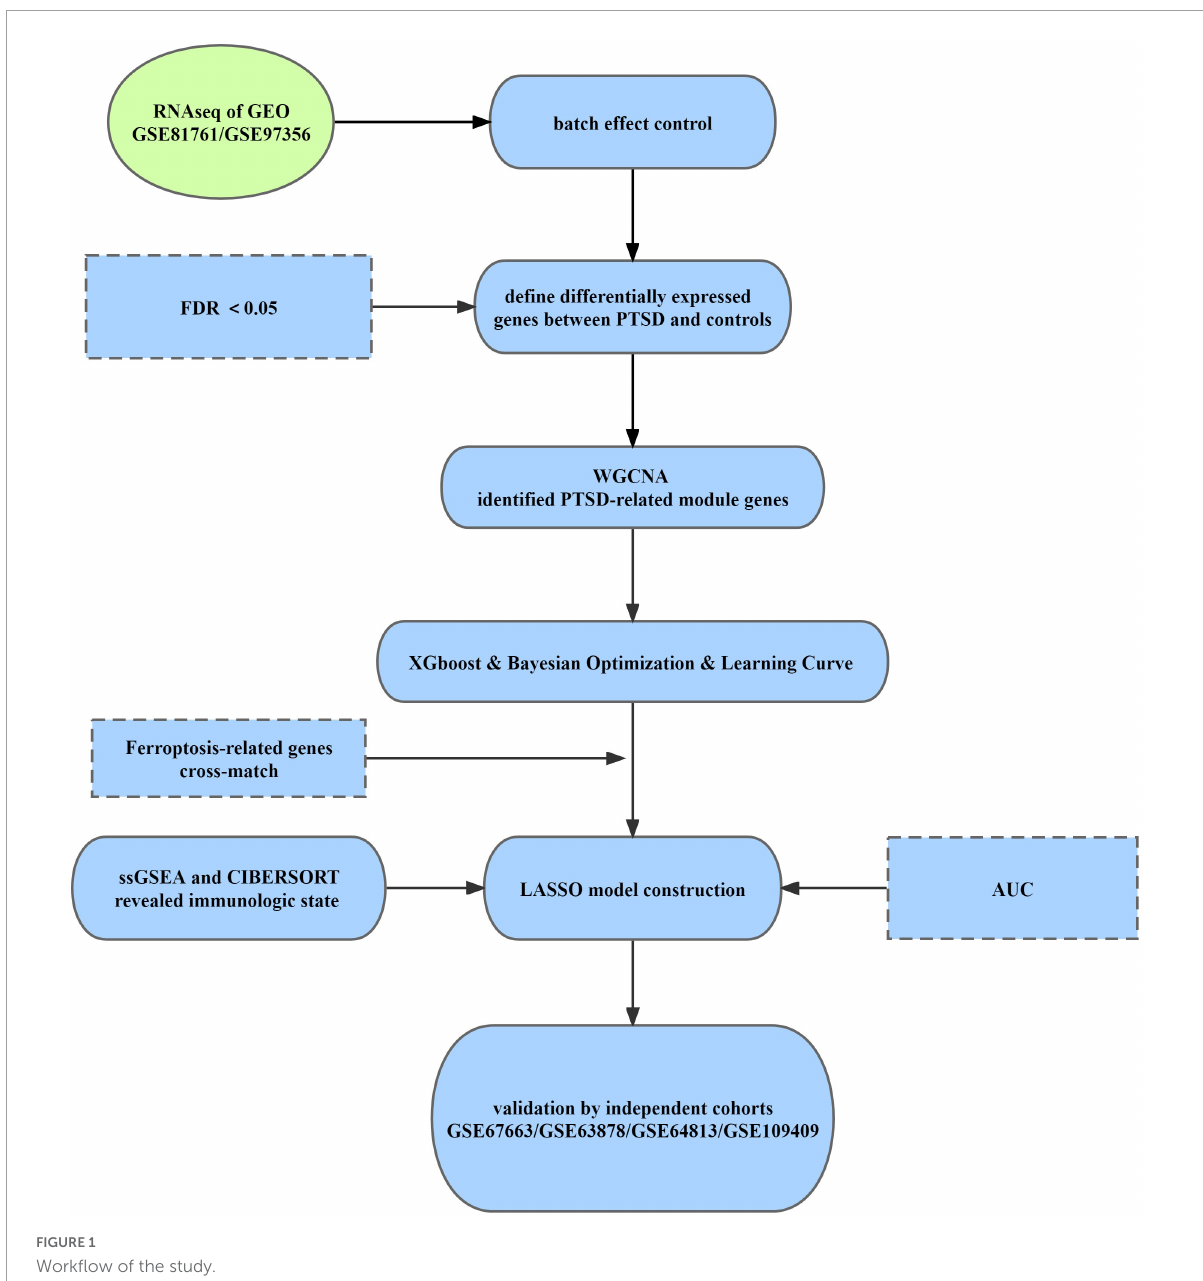
FIGURE1 Workflow of the study.